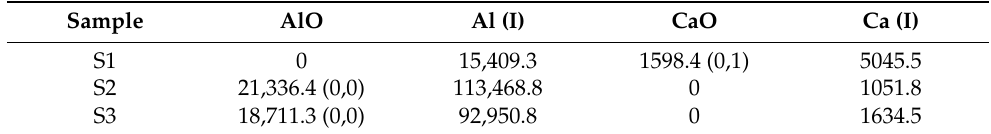
Table 4. The intensity of the electronic bands of AlO and CaO molecules and the intensity of the spectral lines Al and